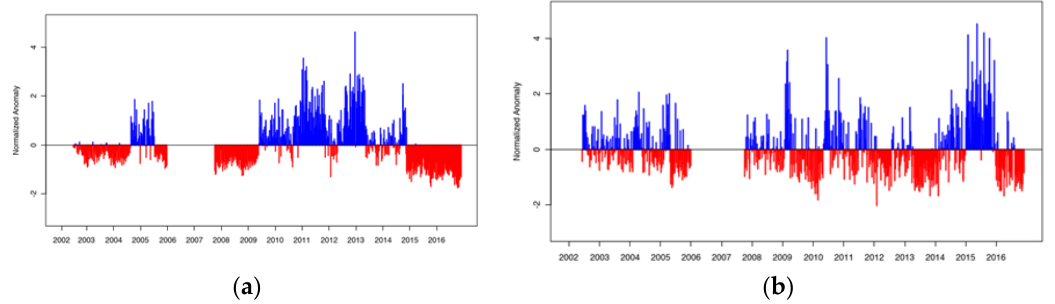
Figure 2. High and low weekly diarrhoea case count anomalies for ( a ) individuals aged 5 years and older and ( b ) children under 5 years of age between 2002 and 2016. Anomalies were normalised for comparison purposes. The anomaly was obtained by removing the linear trend and seasonal climatology of the counts. Colours represent positive (red) and negative (blue) anomalies. Normalisation entailed using the time series counts minus the mean of all counts then divided by the standard deviation.